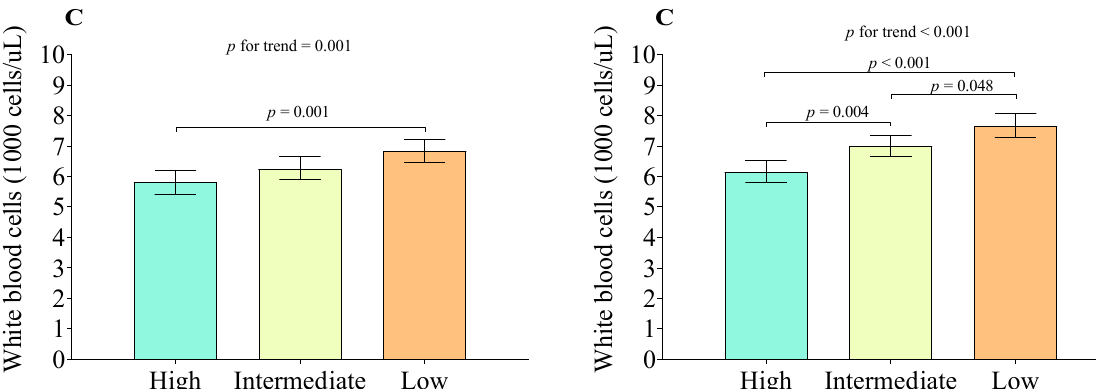
Figure 1. Differences in mean values of total white blood cells count according to the different types of relative handgrip strength and adjusted for age, race/ethnicity, ratio of family income to poverty, physical activity, sedentary behavior and dietary intake. Data expressed as mean (bars) and standard error (lines). ( A ): Normalized handgrip strength by body weight; ( B ): Normalized handgrip strength normalized by body whole body fat; ( C ): Normalized handgrip strength normalized by trunk